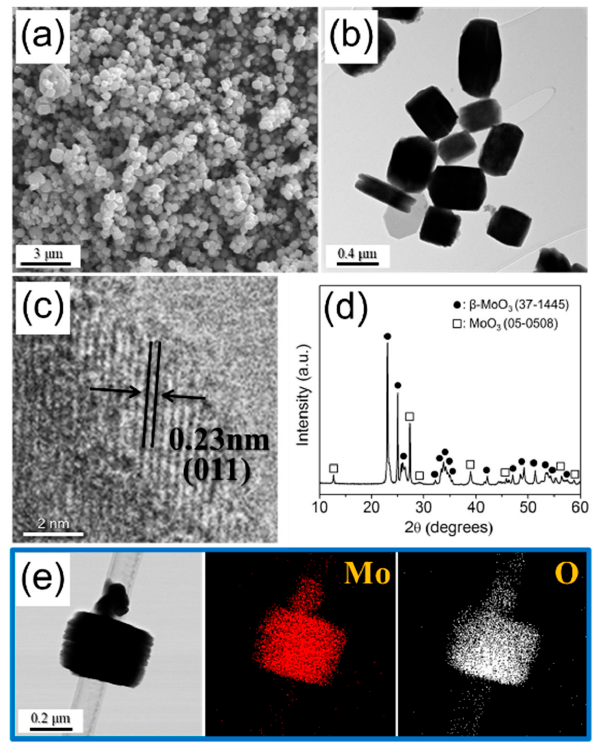
Figure 4. The ( a ) SEM, ( b ) TEM, ( c ) high-resolution TEM images, ( d ) XRD pattern, and ( e ) elemental-mapping images of the bare MoO 3 powders.